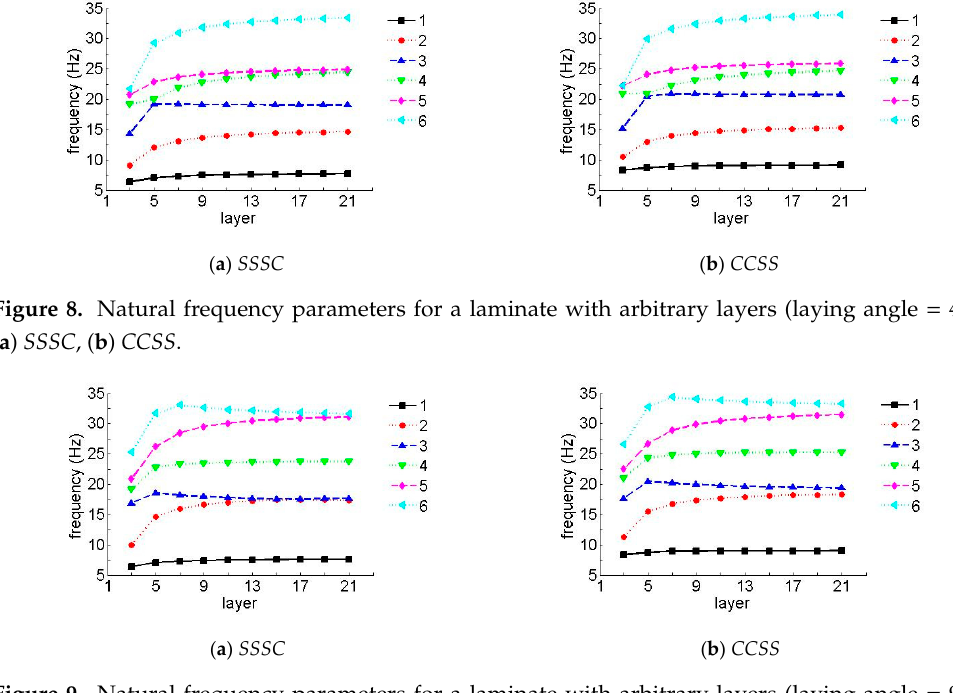
( b ) EEEE _2 Figure 11. Natural frequency parameters for symmetric angle-ply laminates. ( a ) CCSF, ( b ) EEEE _2. The laying angle was another important design parameter of the laminate. Figure 11 shows the variation of the first-order vibration frequency with the laying angle of the composite laminate under different layers. 3.2. Vibration Response Analysis of Laminated Composite Plates In this section, the following example is focused on the vibration harmonic response of the plate. In order to avoid the numerical instability under the excitation of the plate structure resonance frequency in the numerical calculation, the structural damping factor η is introduced in the analysis, and the elastic modulus of the plate structure is correspondingly the complex elastic modulus, E ’ = E (1 + j η ). To avoid the instability of the response at the resonant frequency, the damping factor η (loss factor value) of the plate structure herein is η = 0.01.